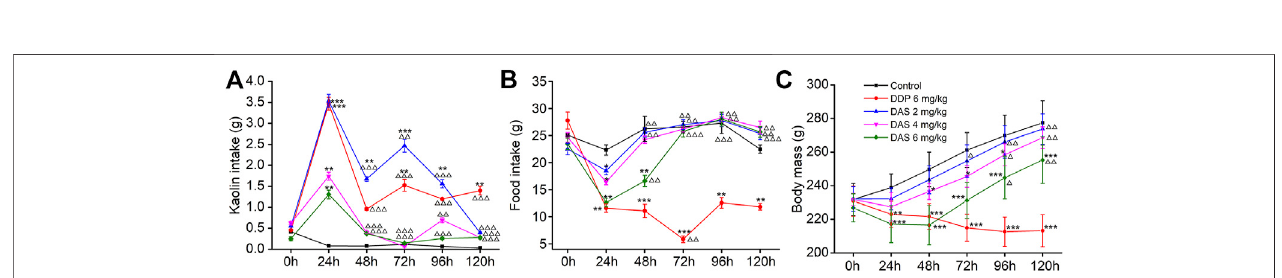
FIGURE 2 | Effects of cisplatin (DDP) on kaolin intake (A) food intake, (B) and body mass, (C) in rats after a single administration (3 and 6 mg/kg, i. p.). Results of kaolin and food intake are shown as cumulative daily amounts (g) during 24 h periods up to 96 h after treatment. Body mass was weighed once per day. The data are expressed asmean ± SEM.Statisticalsigni fi cancewasassessedusingtheone-wayANOVA.* p < 0.05, ** p < 0.01, *** p < 0.001vs.theNCgroup, △ p < 0.05, △△ p < 0.01, △△△ p < 0.001 vs. at 24 h.